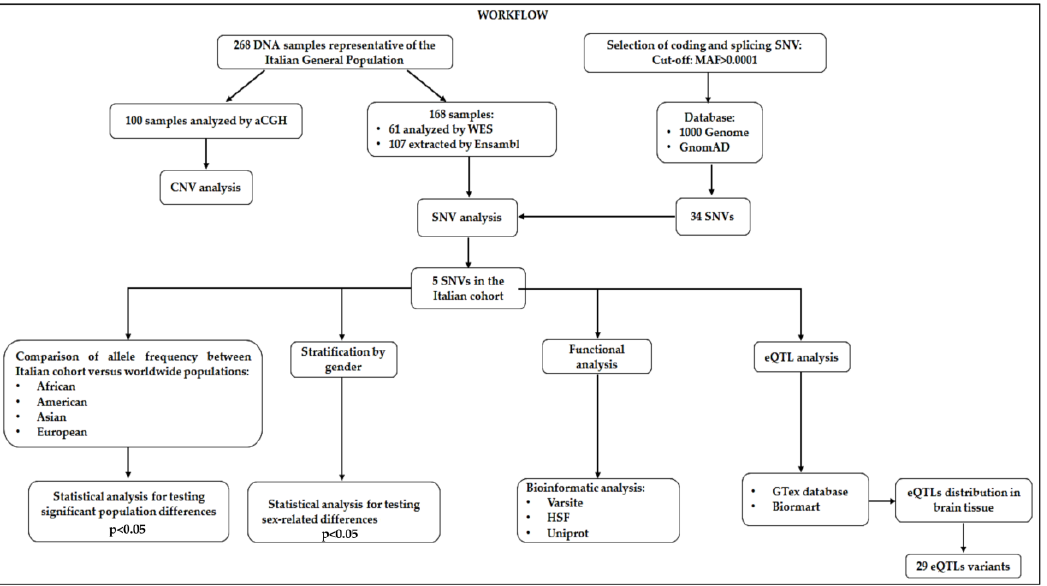
Figure 1. Workflow of the analytical steps performed in the study. CNV: copy number variation; SNV: single nucleotide variants; MAF: minor allele frequency; HSF: human splicing finder, eQTL: expression quantitative locus.